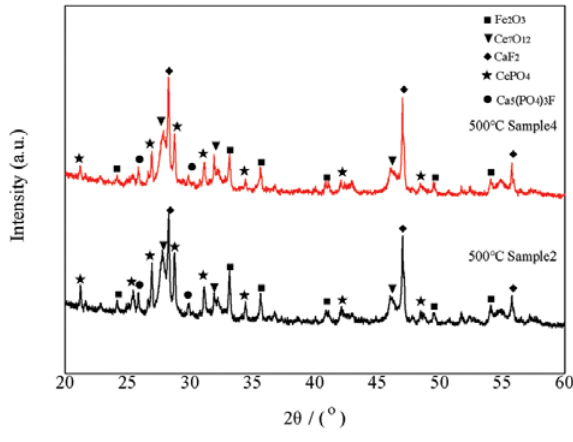
Figure 11: XRD of Sample 2/4 roasting at 500°C.